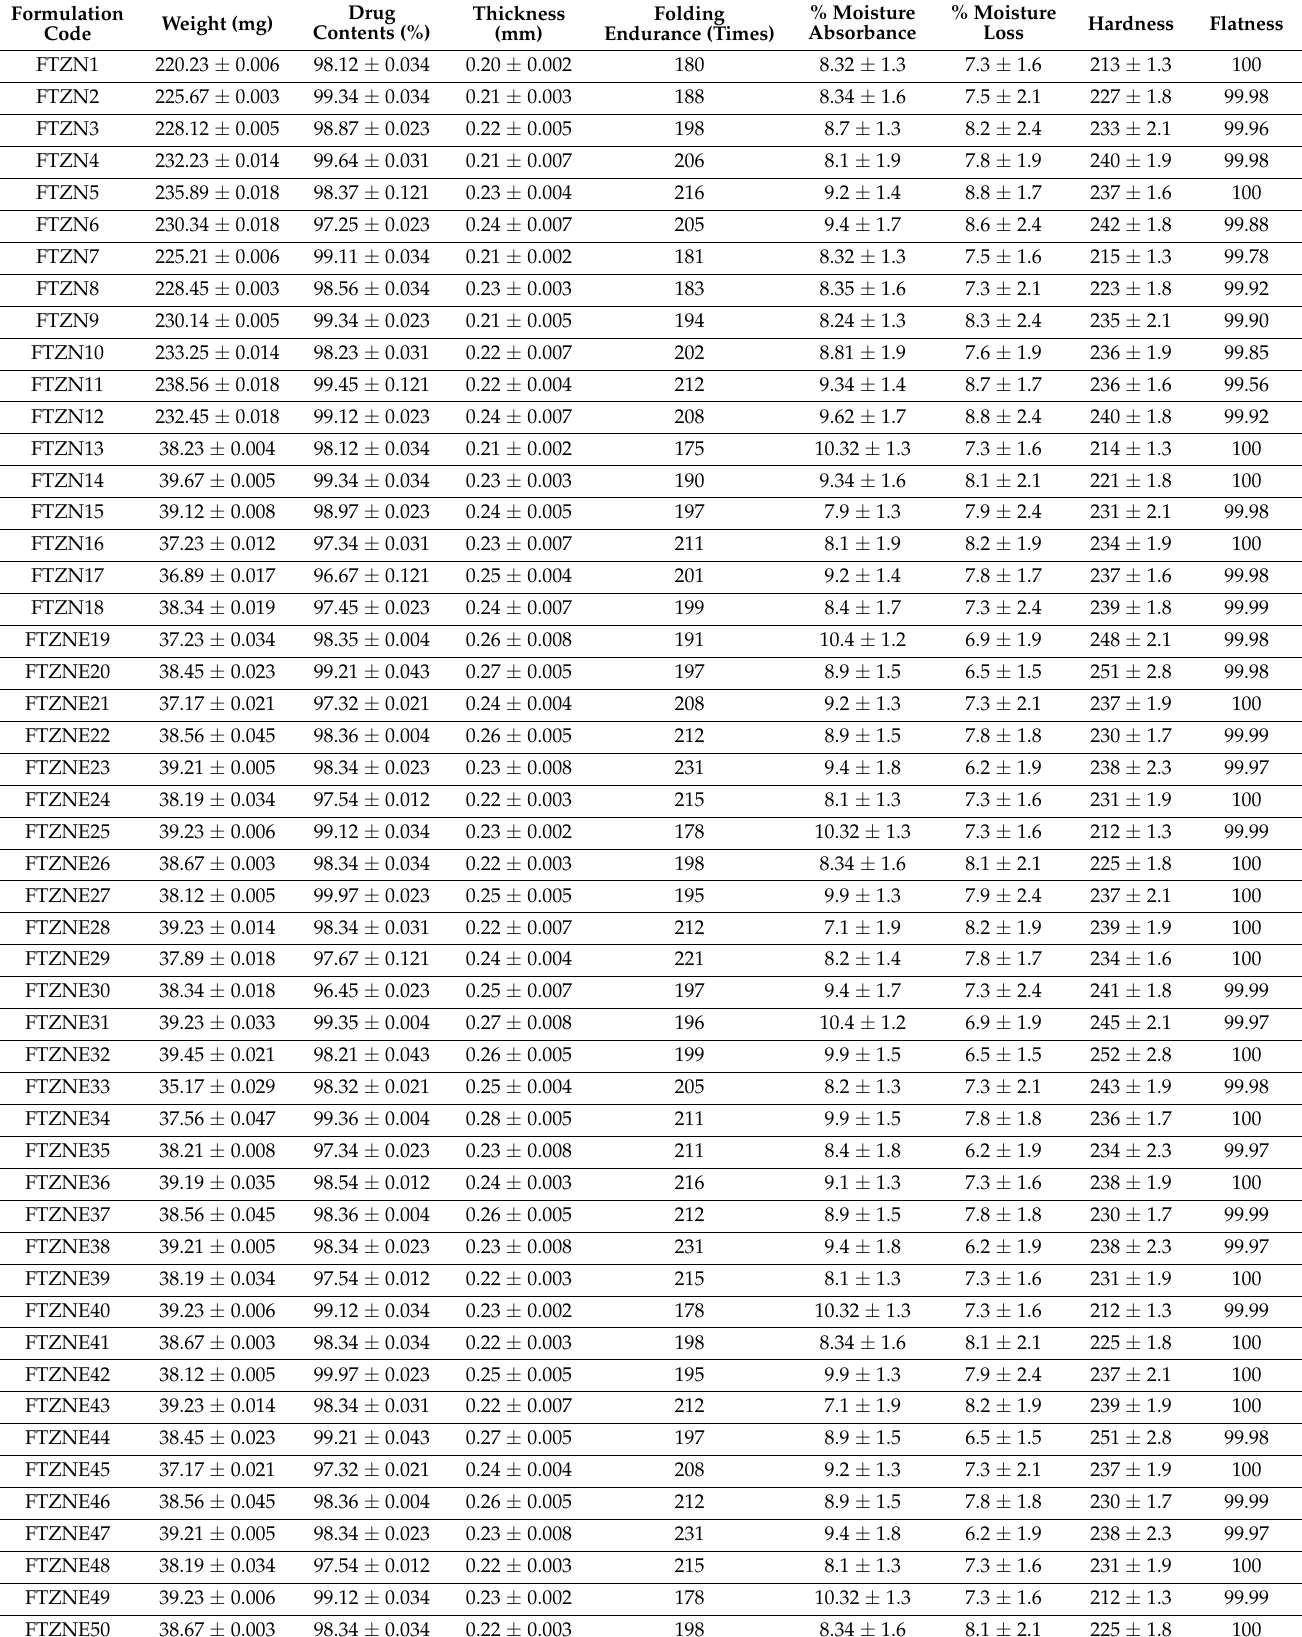
Table A3. Tizanidine transdermal patch physical parameters and drug contents and permeation enhancer, n = 3, mean ± S.D. Formulation